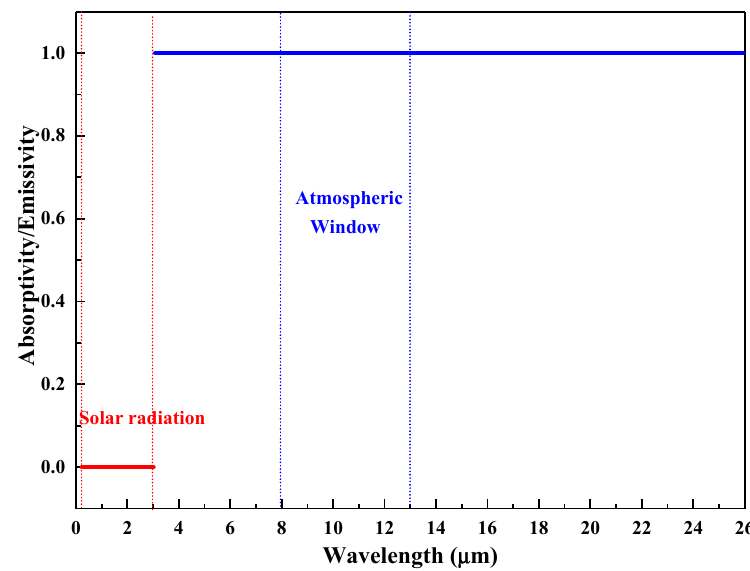
Figure 4. Variation of an ideal radiator’s emissivity/absorptivity with wavelength.